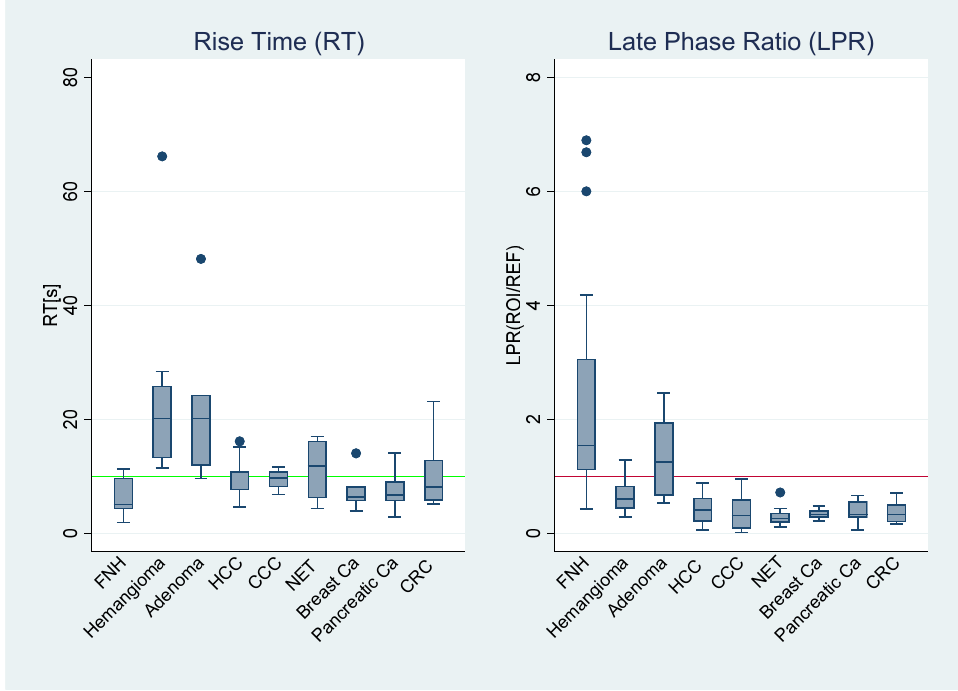
Figure 7. Box plots over all sub-entities. Rise time (RT) and late phase ratio (LPR) of all sub-entities. The green reference line is at 10 s, the red line at “1” distinguishes hyper- and hypoechogenicity of the liver lesions in the late phase. NET/Breast Ca/Pancreatic Ca/CRC denote the corresponding liver metastasis. FNH: focal nodular hyperplasia; HCC: hepatocellular carcinoma; CCC: cholangiocellular carcinoma; NET: neuroendocrine tumor; CRC: colorectal carcinoma.